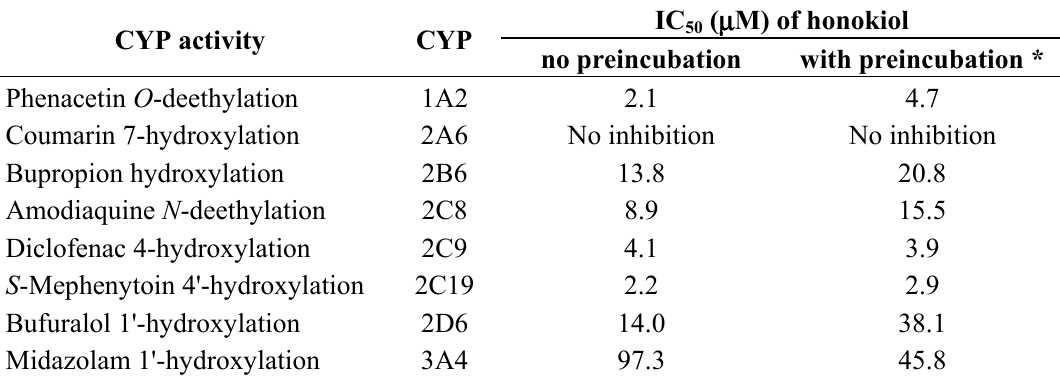
Table 1. Effect of honokiol on CYP metabolic activity in pooled human liver microsomes